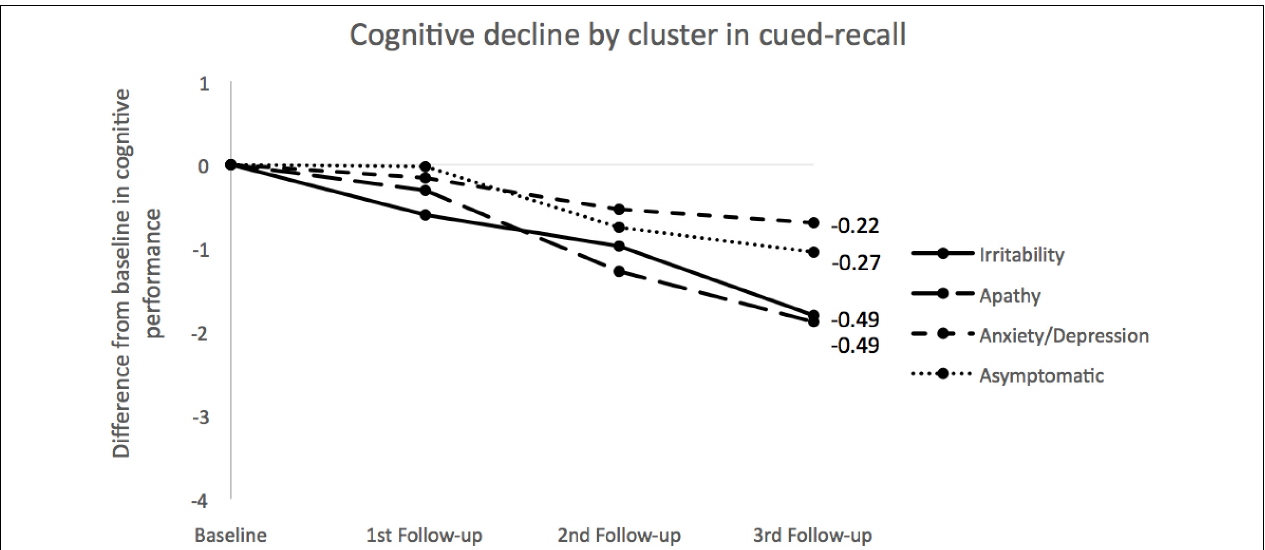
FIGURE 2 | Cognitive decline across clusters for cued-recall. Measures for each group were obtained using LMM means by calculating differences between baseline and follow-ups for each time point. Slopes for each cluster were calculated using the 2-known points approach. Negative values correspond to decrements: the larger the absolute values the steeper the line. Numbers at the end of the lines indicate the cognitive slopes for each